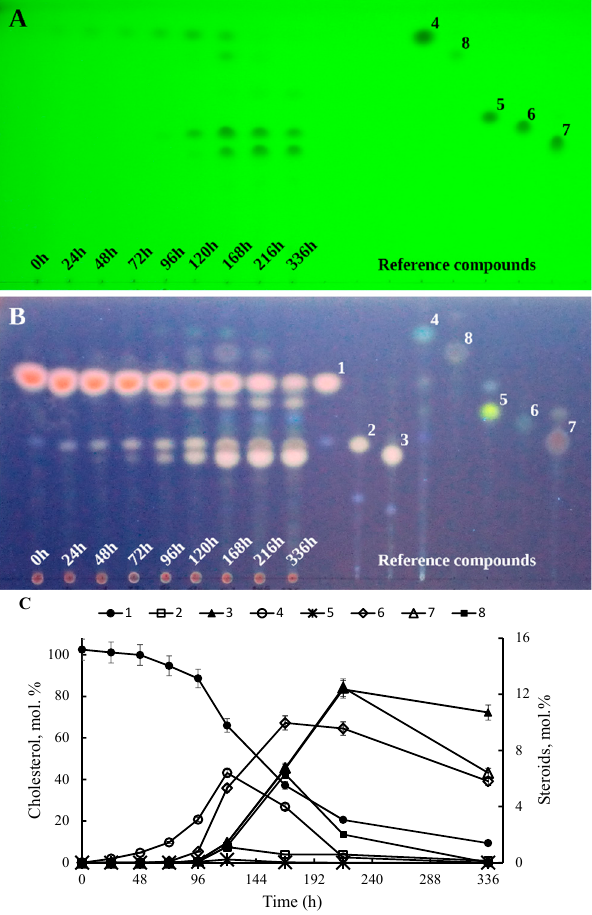
Figure 1. Cholesterol conversion by S. hirsuta in a mineral medium. ( A ) Identification under UV-light (254 nm). ( B ) TLC-plate staining with a MnCl 2 solution followed by identification under UV light (365 nm). Each sample volume was 100 µ L ( A , B ). ( C ) Kinetics of steroid products accumulation and cholesterol utilization (HPLC data). Designations: 1, cholesterol; 2, 26-hydroxycholesterol; 3, 3 β -hydroxycholest-5-en-26-oic acid; 4, cholest-4-en-3-one; 5, 26-hydroxycholest-4-en-3-one; 6, 3-oxo-cholest-4-en-26-oic acid; 7, 3-oxo-cholesta-1,4-dien-26-oic acid; 8, cholesta-1,4-dien-3-one.